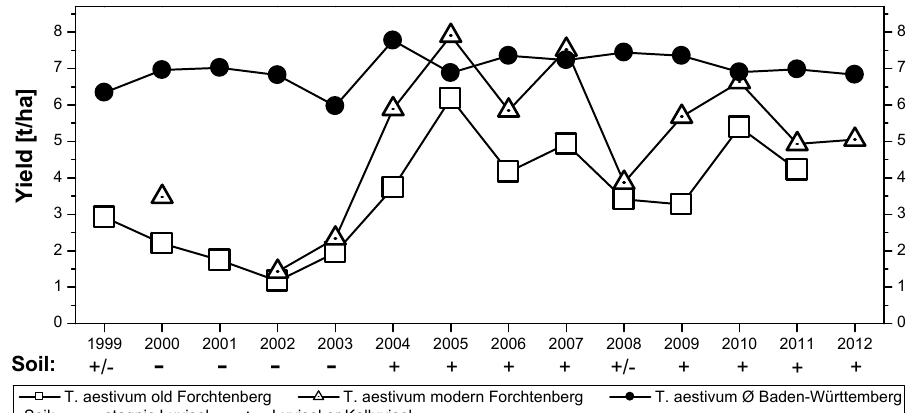
Figure 6. Triticum aestivum (winterwheat) yields after burning in Forchtenberg and long-term averages for modern agriculture in Baden-Württemberg (Bundesministerium für Ernährung, Landwirtschaft und Verbraucherschutz 2013) (Ehrmann, et al. [29]).